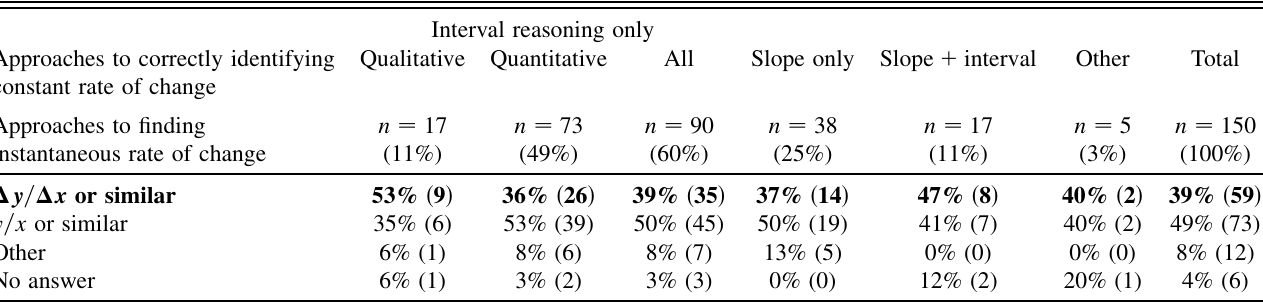
TABLE X. Post-test results linking the reasons students gave for correctly identifying constant rate with how they determined a value for the rate of change at one particular instant. For an example of how to read the table, see the caption of Table